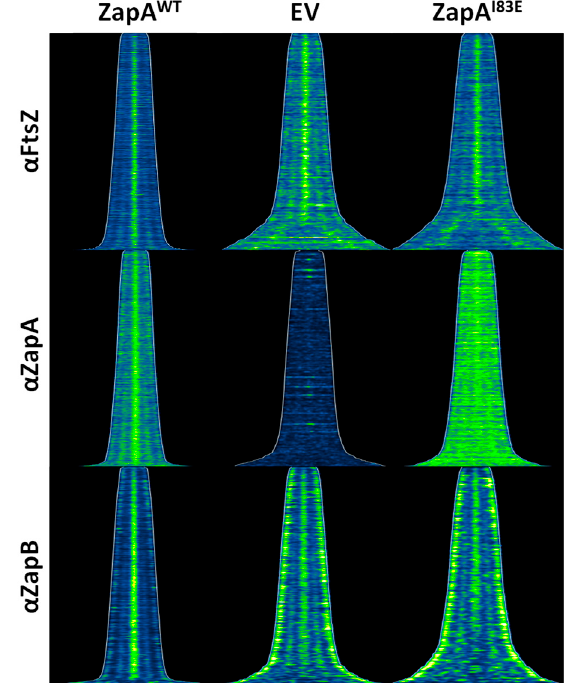
Figure 2. ZapA I83E mainly localizes throughout the cytoplasm and does not complement ∆ zapA cells based on the loss of specific Z-associated protein B (ZapB) localization. Maps of fluorescence profiles of TB28 ∆ zapA cells expressing wild-type Z-associated protein A (ZapA), an empty vector control (EV) or ZapA I83E immunolabeled with antibodies against filamenting temperature-sensitive Z (FtsZ), ZapA, or ZapB. Cells are sorted according to cell length using ObjectJ [17] and the fluorescence intensities of each labeling is shown at identical brightness and contrast values for direct comparison. Images of immunolabeled cells and average profiles along the cell cycle are presented in Figure